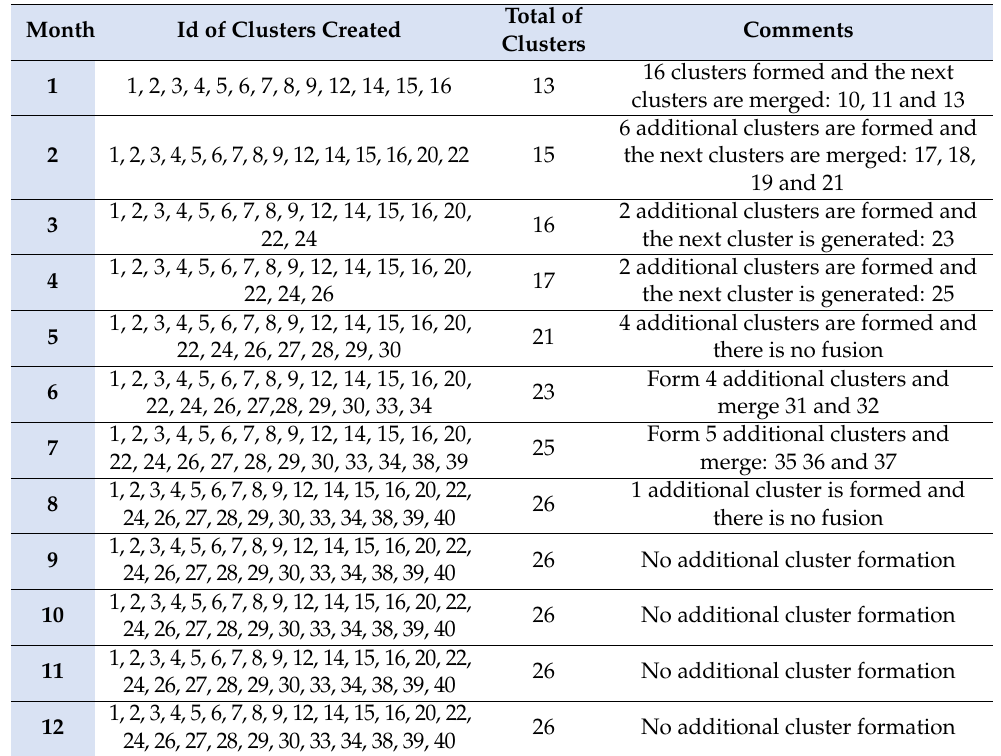
Table 2. Creating and merging clusters with